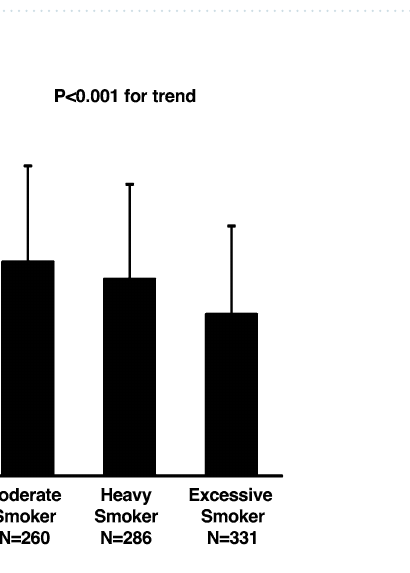
Table 4. Clinical characteristics of never smokers and current smokers in men. All results are presented as mean ± SD. HDL, high-density lipoprotein; LDL, low-density lipoprotein.